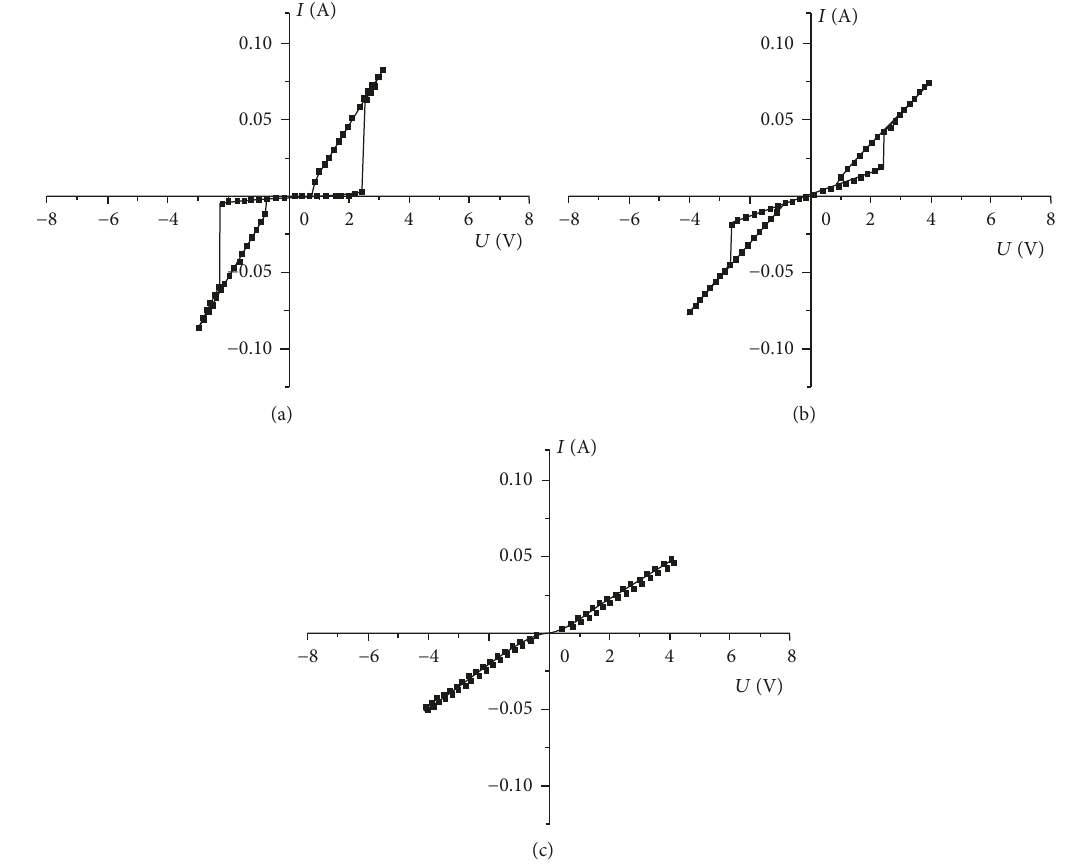
Figure 14: (a) I-V curves of the V 2 O 5 ⋅ 1.8H 2 O based MOM structures: (a) after W implantation for 1min, electroformed; (b) after